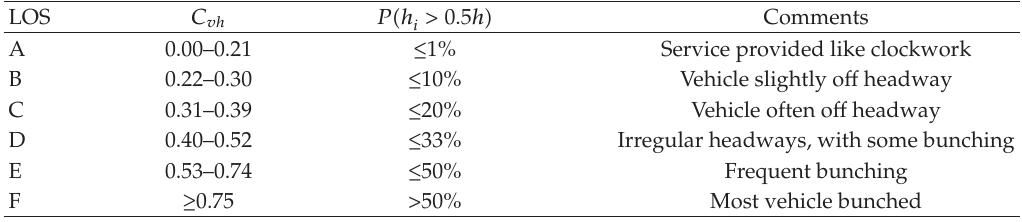
Table 1: The level of service classified by C vh for fixed-route bus